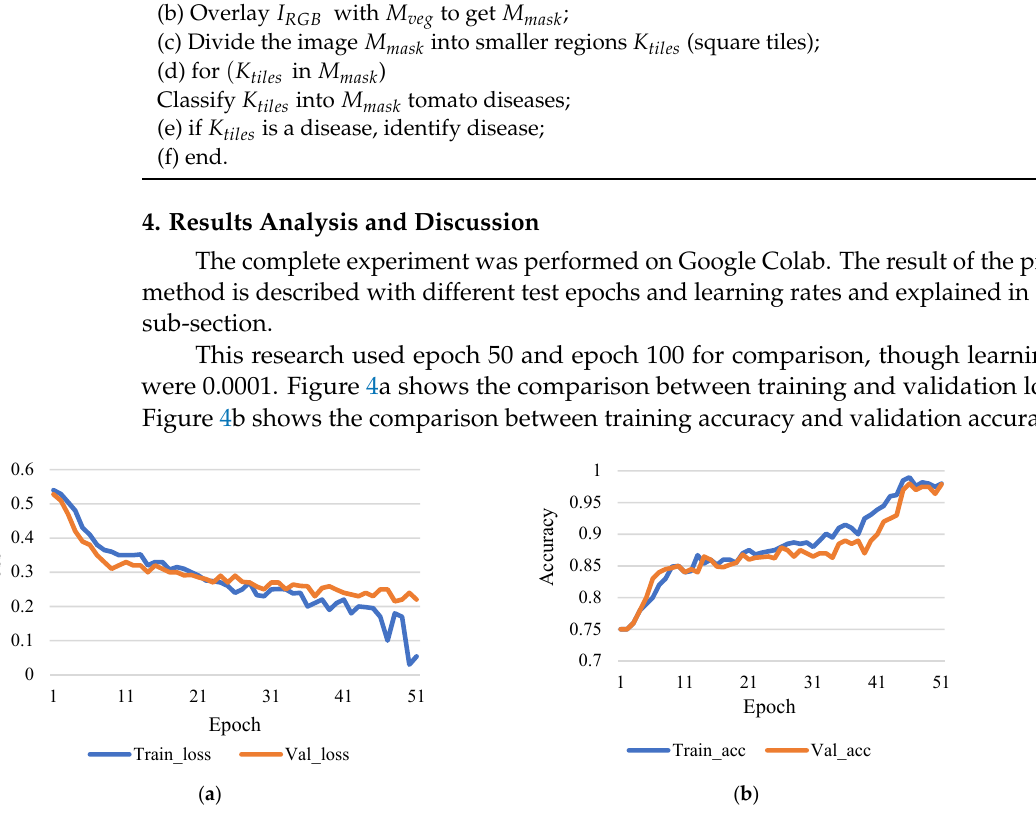
Step 4 : Divide the image M mask into smaller regions K tiles (square tiles).